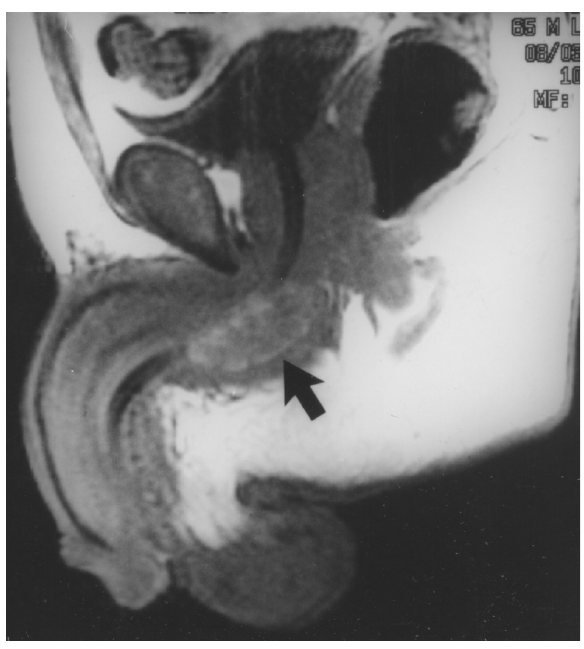
Figure 1 – Nuclear magnetic resonance imaging showing ure- thral metastatic lesion (arrow).